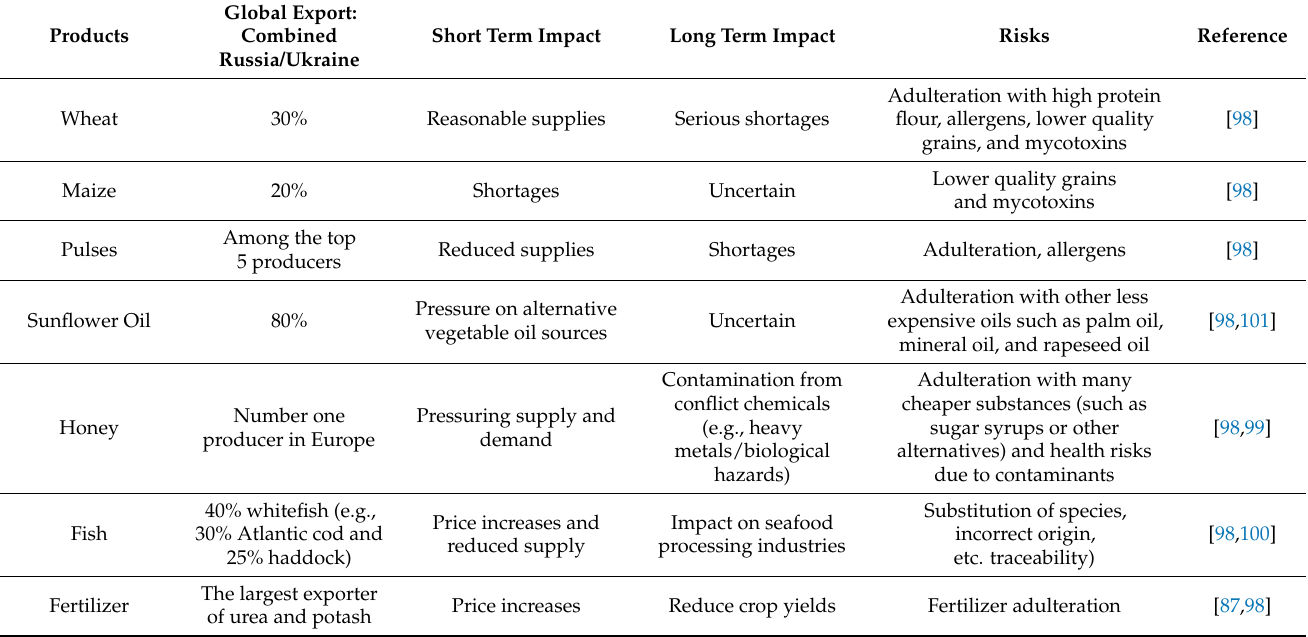
Table 4. Impact and risk associated with certain food products that are particularly affected by the Russian invasion of